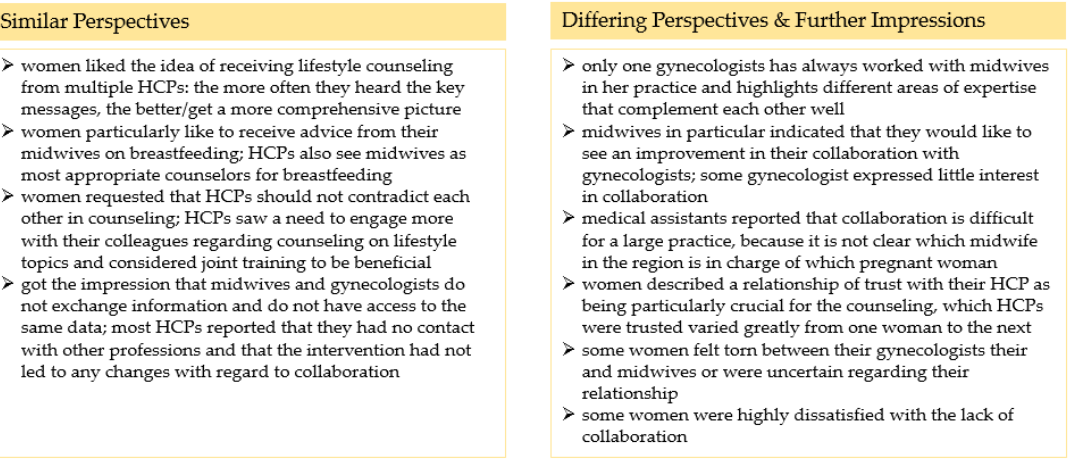
Figure 6. Summary of the results in Section 3.5.